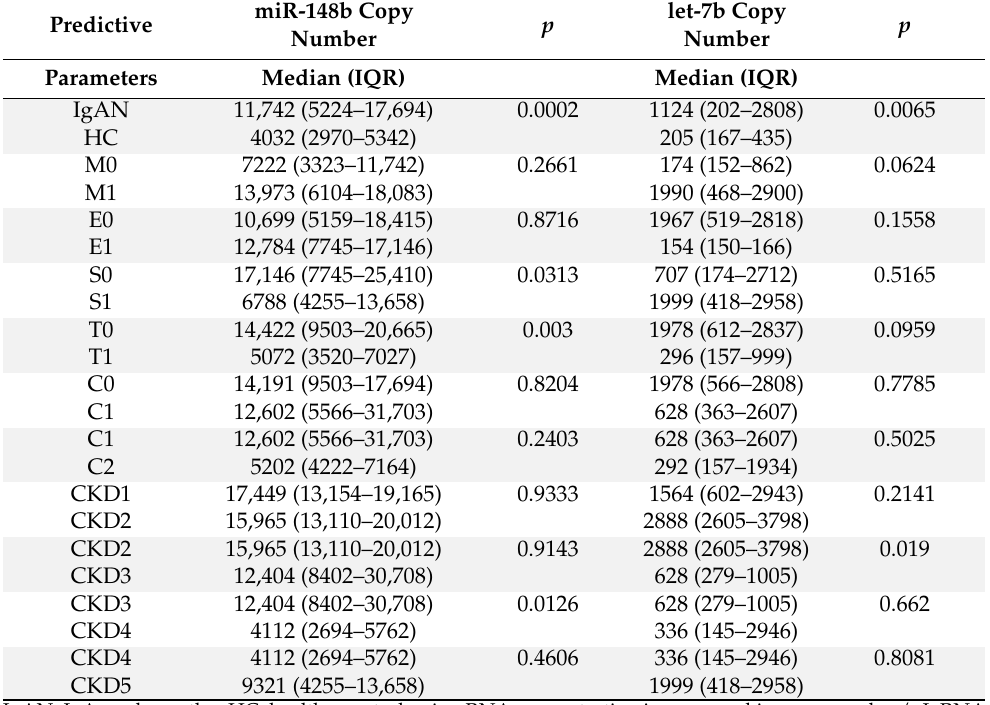
Table 1. microRNA concentrations (copy